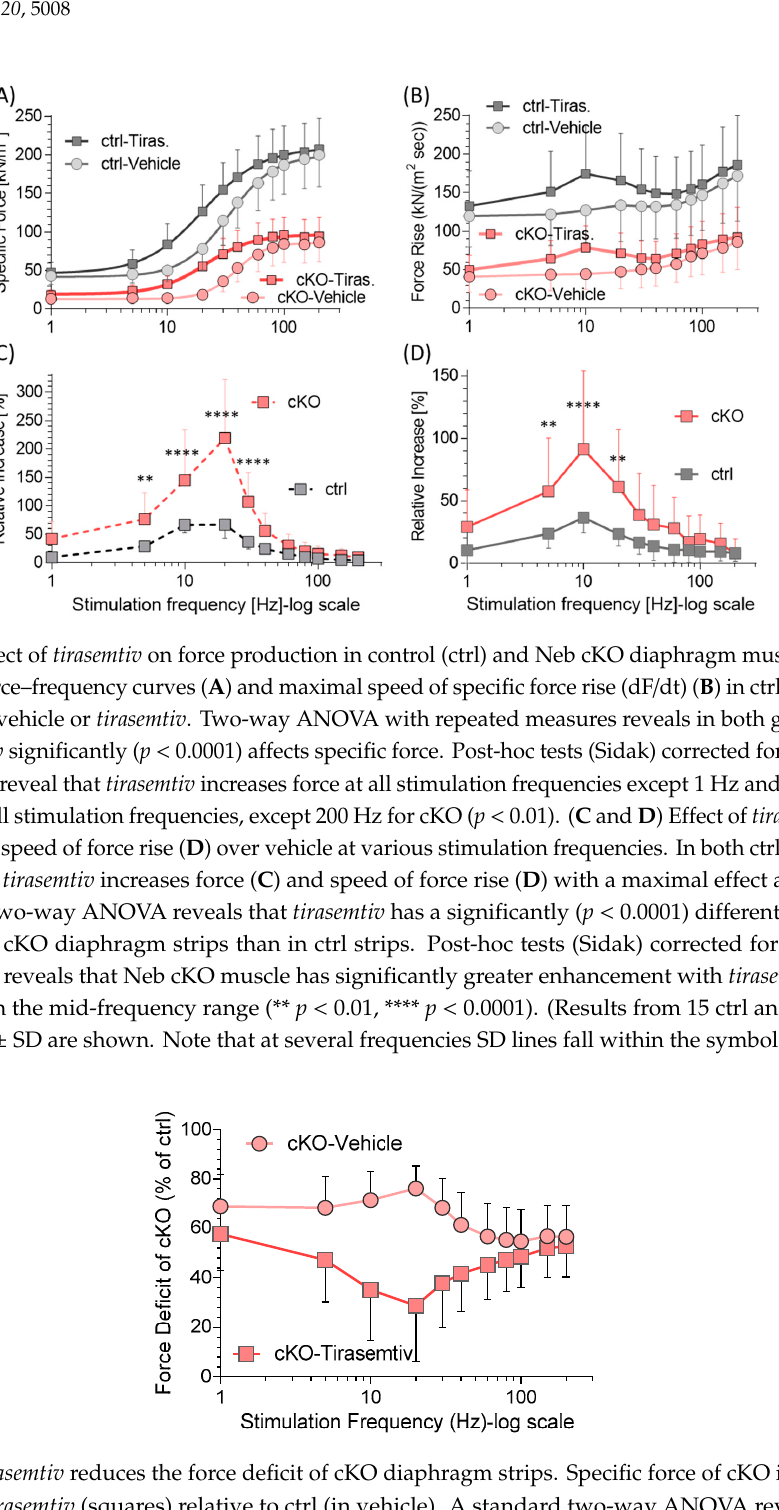
2.5 ± 0.5* Asterisk: significant difference between tirasemtiv and vehicle; hashtag: significant difference between genotypes. 2.2. Effect of Tirasemtiv on Diaphragm Muscle Strip The effect of the FSTA tirasemtiv on specific force was evaluated in ctrl and NM diaphragm muscle. Tirasemtiv increased specific force, in both genotypes and at all stimulation frequencies (Figure 2A, Table 1, Suppl tableS1). Similarly, the maximal speed of specific force rise (dF/dt max) increased in both genotypes (Figure 2B). The increase in both specific force and speed of force rise